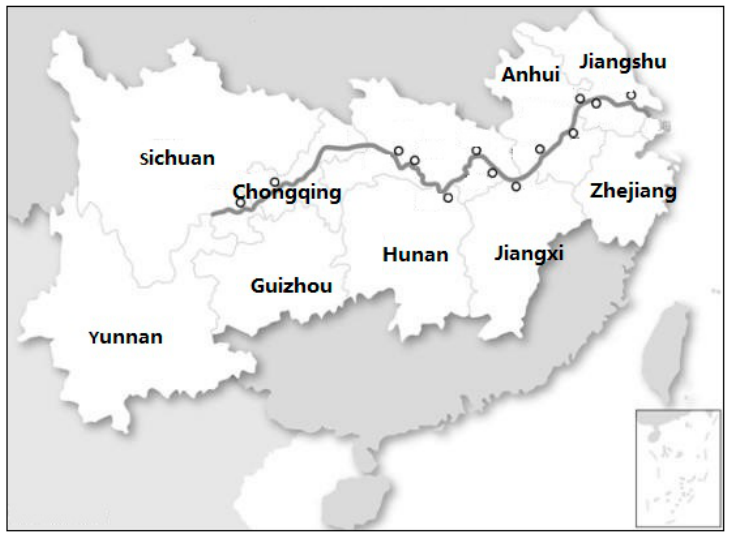
Figure 1. Location Map of the Yangtze River Economic Belt.